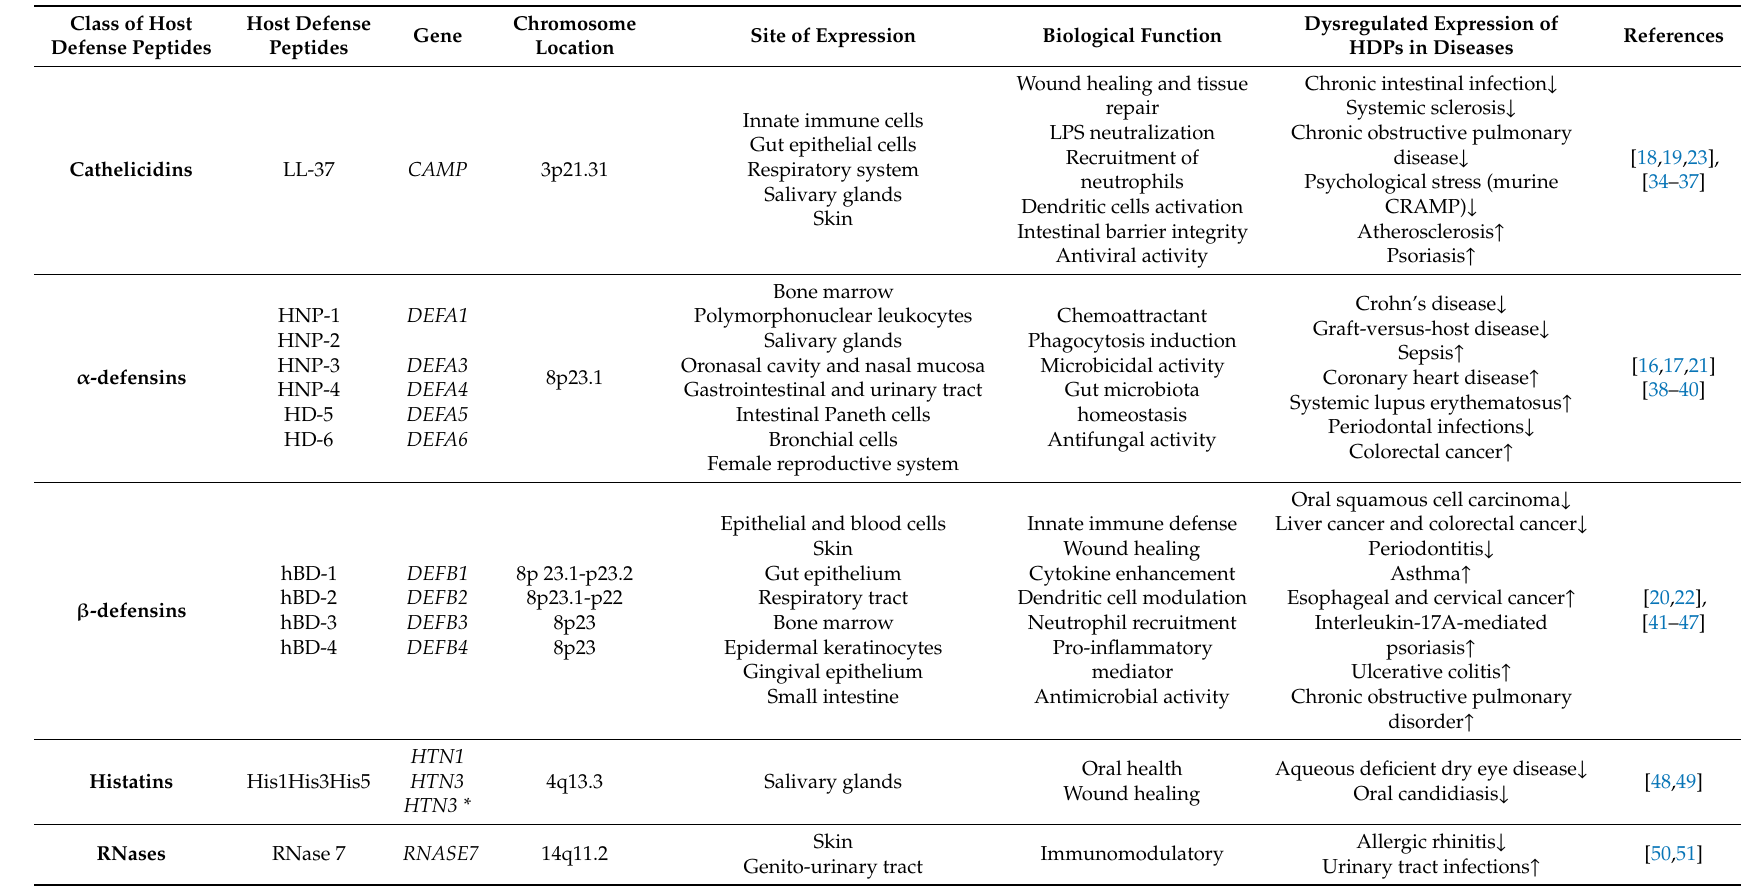
Table 1. Host defense peptides—antimicrobial and immunomodulatory functions and disease